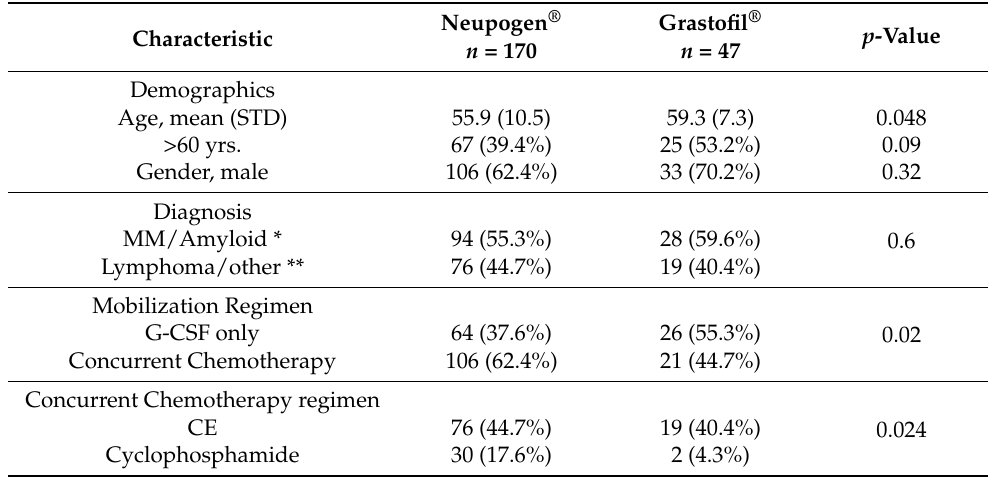
Table 1. Demographics/ Descriptive